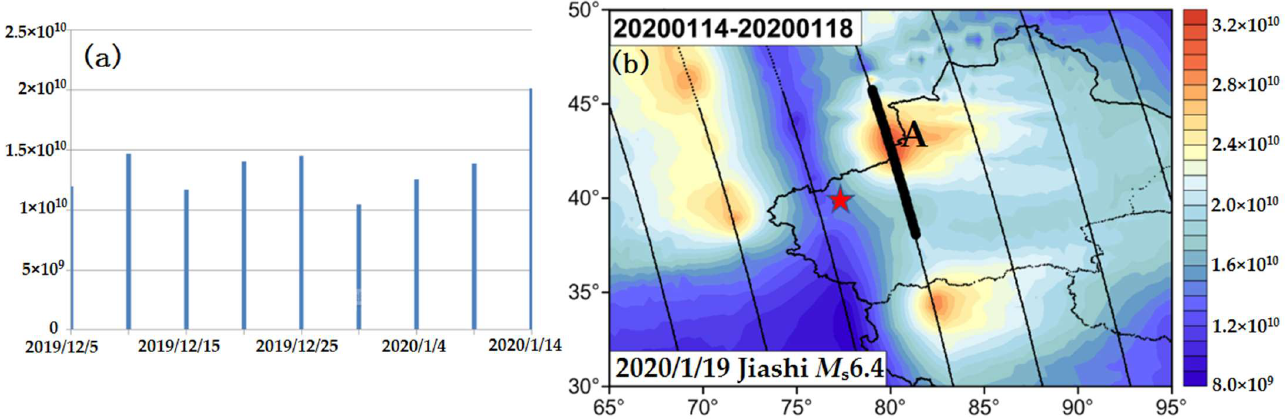
Figure 6. Electron density changes observed by Zhangheng-1 satellite before Jiashi M6.4 earthquake. ( a ) electron density, ( b ) the orbital position of the study area, and spatial distribution of anomalous area. The pentagram is the epicenter, and the black straight line is the orbit of the satellite in figure